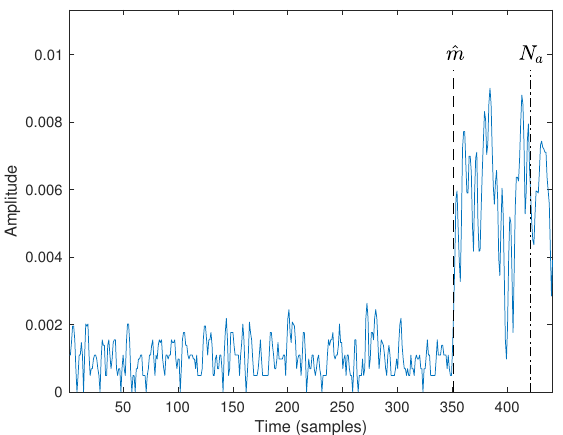
Figure 7. Estimated transient starting point ˆ m and alarm time N a .